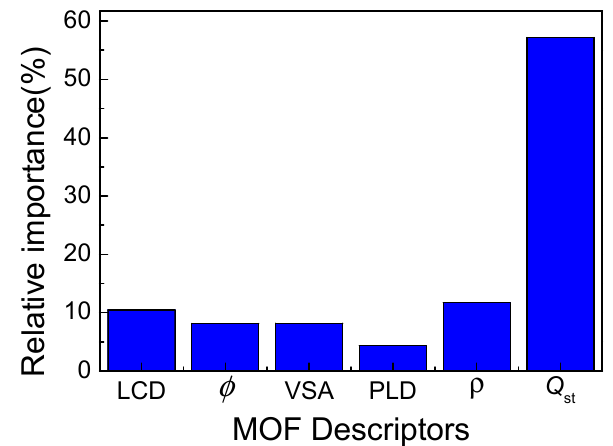
Figure 5. Predicted by the Random Forest, the relative importance of the six descriptors for adsorption selectivity.